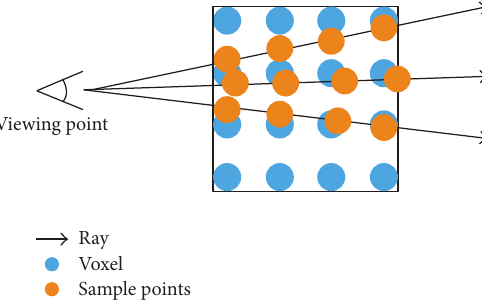
Figure 21: The concept of volumetric ray